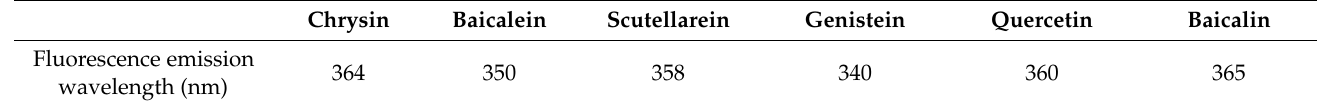
Table 2. Emission wavelengths for fluorescence detection of active